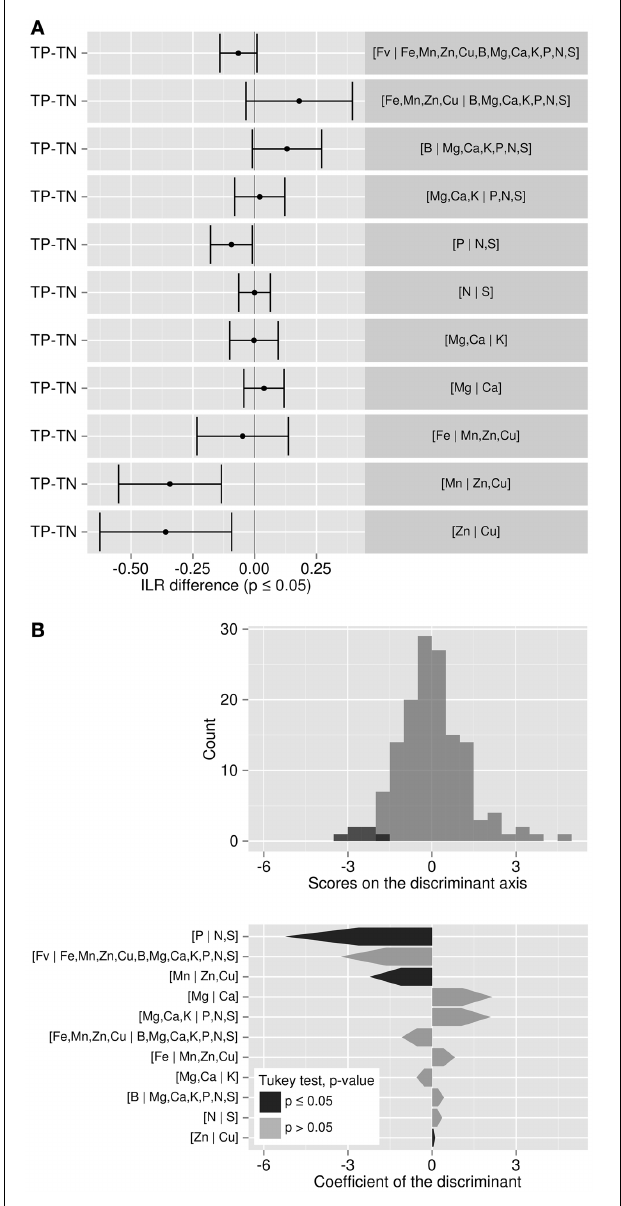
FIGURE 4 | (A) Tukey test of ilr differences between TP and TN specimens: where balance difference is negative, components on the left side of the balance load more than those on the right side for TP specimens. (B) Discriminant analysis between TP and TN specimens.